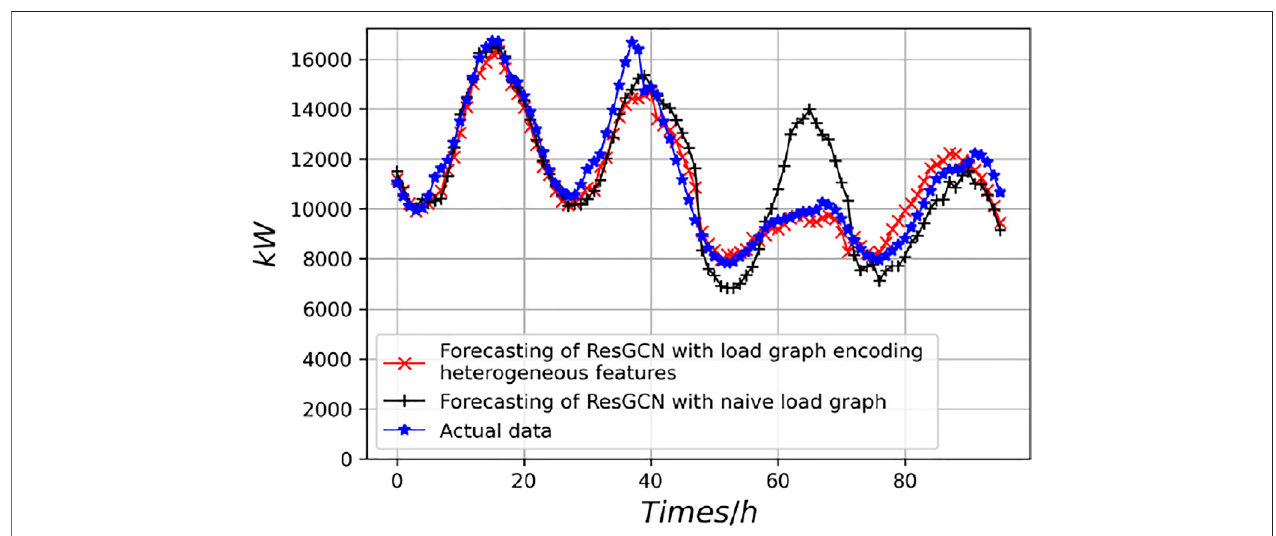
FIGURE 13 | Short-term load forecasts with and without considering effects of COVID-19 (2020.10.23-2020.10.26).